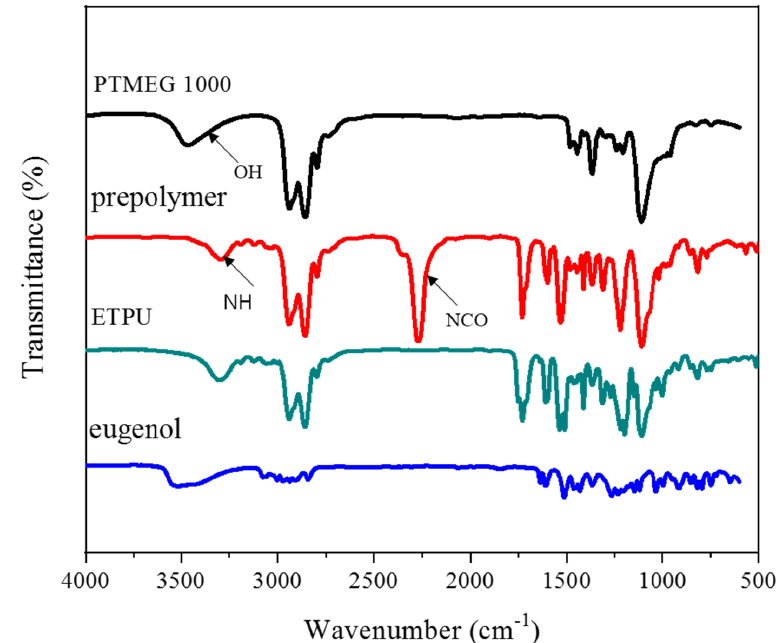
Figure 1. FT-IR spectra of Poly (tetramethylene ether glycol) (PTMEG), prepolymer, eugenol, and eugenol terminated polyurethane prepolymer (ETPU).